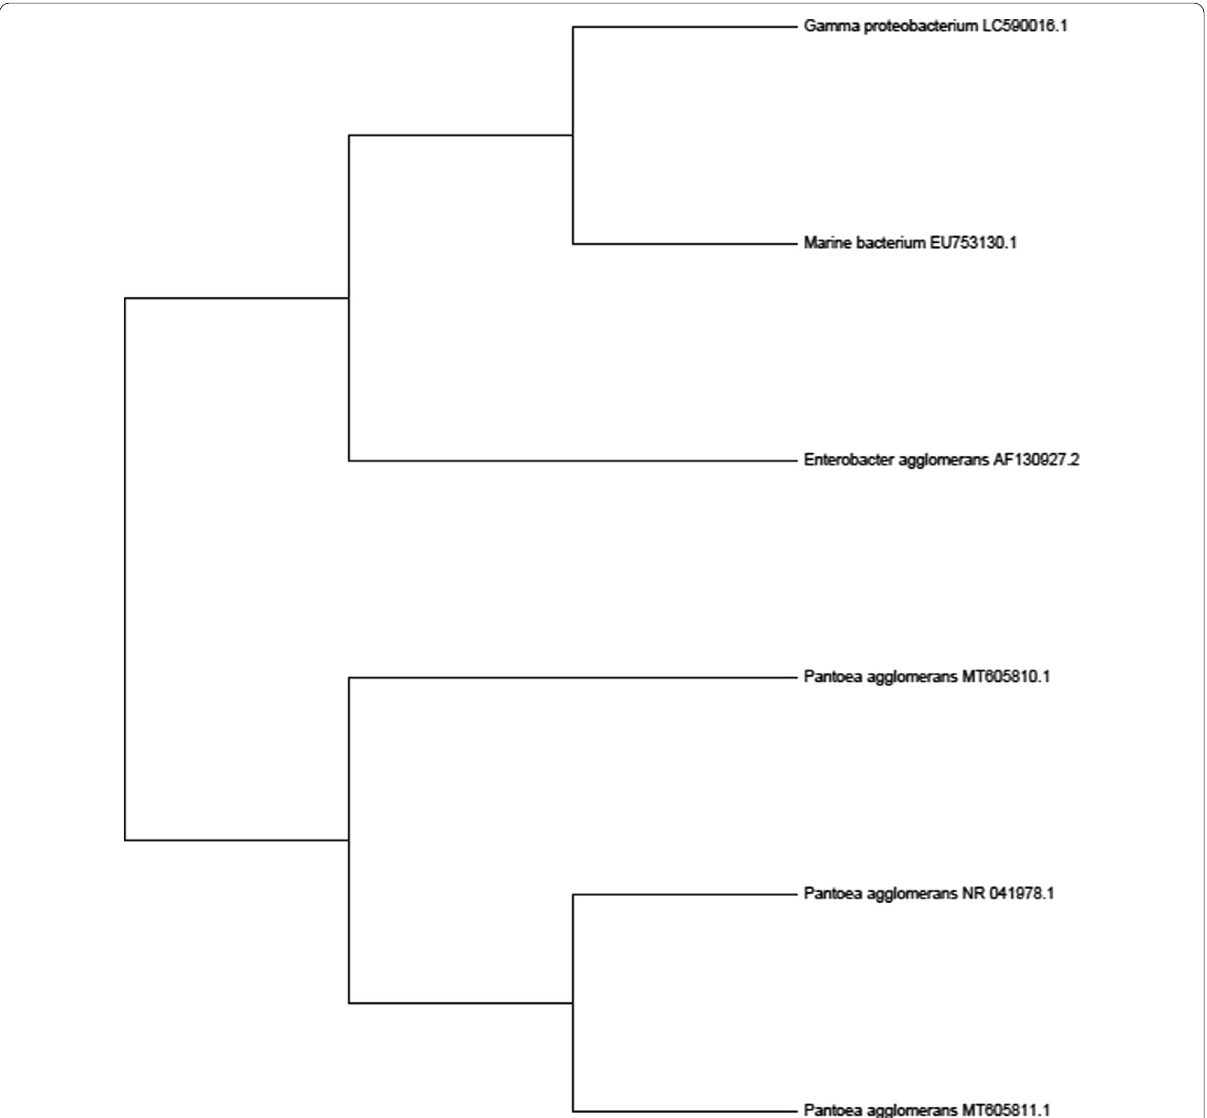
Fig. 2 Phylogenetic analysis of Pontoea isolates on ITS gene. This analysis was performed using the neighbor‑joining method in BLAST pairwise